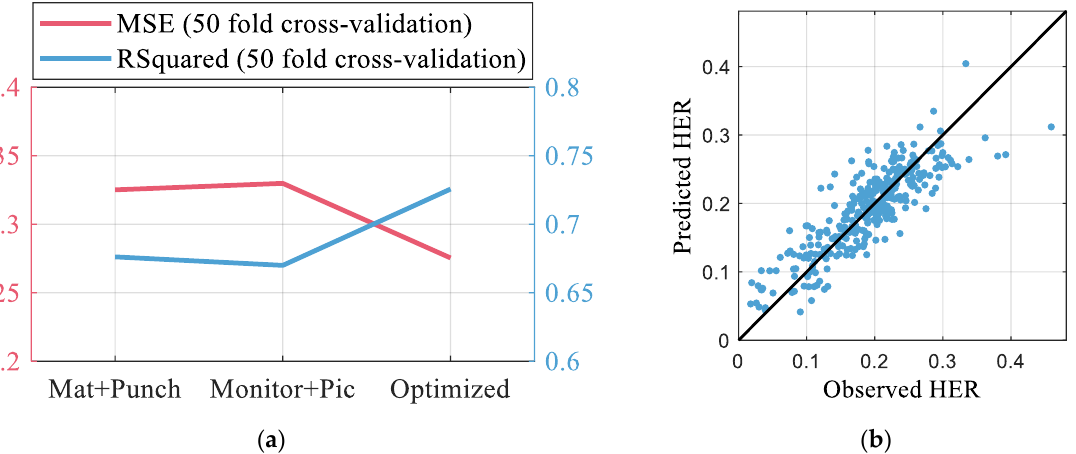
Figure 13. Result of HER prediction with selected feature set. ( a ) Comparison of prediction perfor- mance. ( b ) Prediction result with optimized feature set.